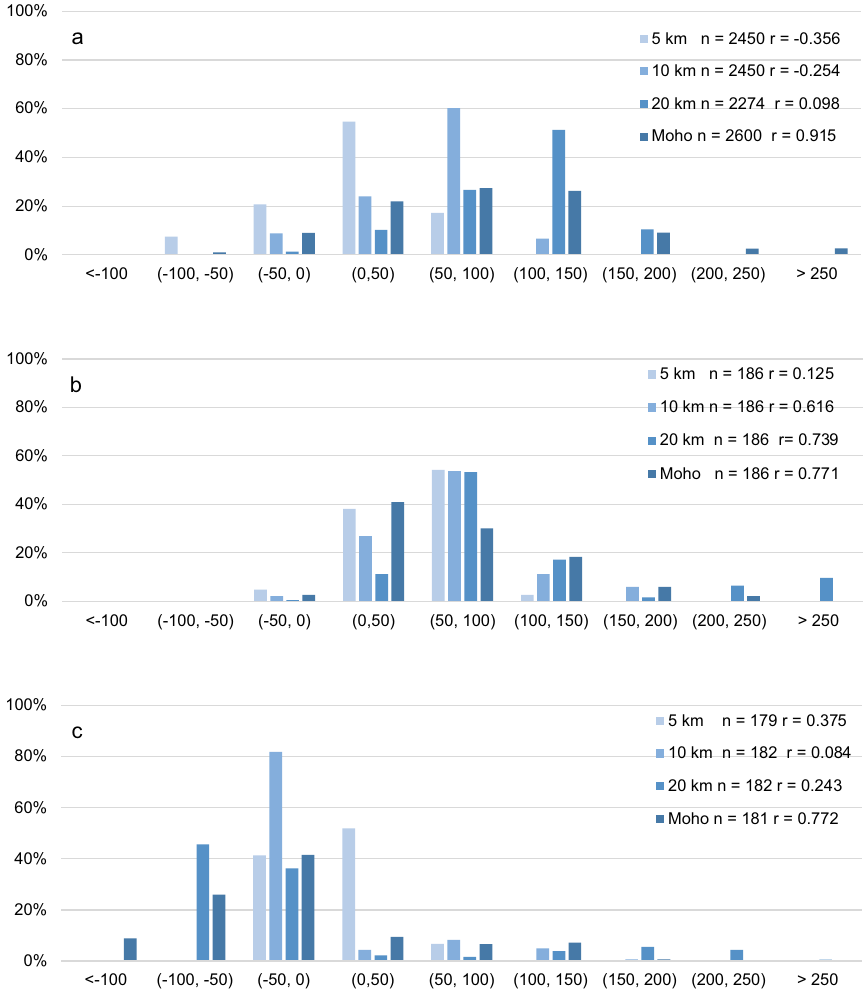
Fig. 9 Temperature differences and correlation coefficient between the regional thermal models of Fullea et al. (2021) and Torne et al. (2015) and the N–S 2D profile of Carballo et al. (2015a) at 5 km, 10 km, and 20 km and at Moho depth. See Fig. 3b for location and text for details. Comparison of: (a) the regional model of Fullea et al. (2021) vs the model of Torne et al. (2015); (b) comparison of the N–S 2D profile of Carballo et al. (2015a) vs the regional model of Torne et al. (2015); (c) comparison of the N–S 2D profile of Carballo et al. (2015a) vs the regional model of Fullea et al. (2021). n : number of analyzed points. r